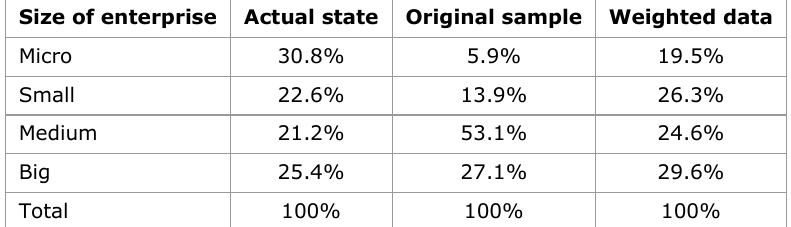
Table 1. Employee actual structure and share of respondents in sample